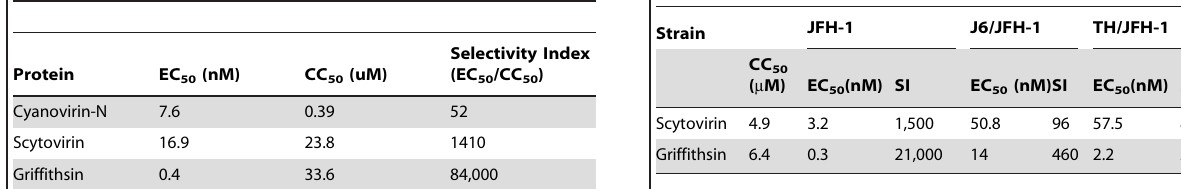
Table 1. Activity of oligomannose-specific lectins from natural product extracts in HCV cell culture assay for inhibition of the type 2a JFH-1 strain of HCV. a